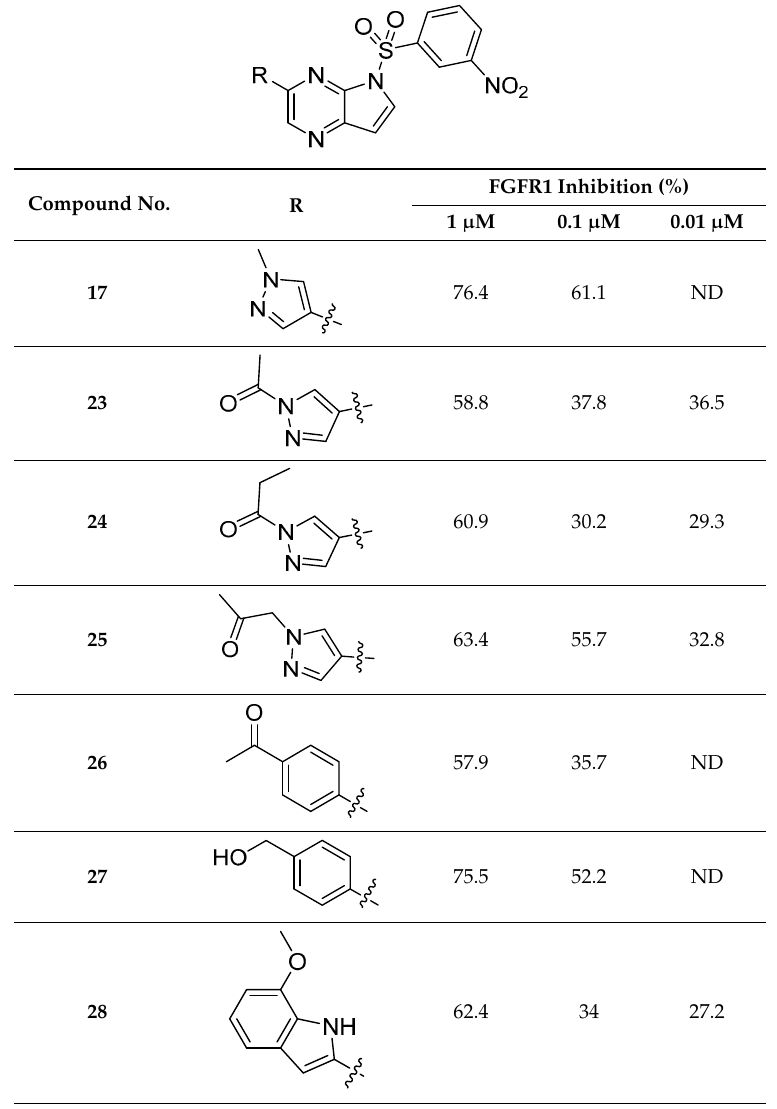
Table 4. Structures and FGFR1 enzymatic activities of compounds 23 – 28 .